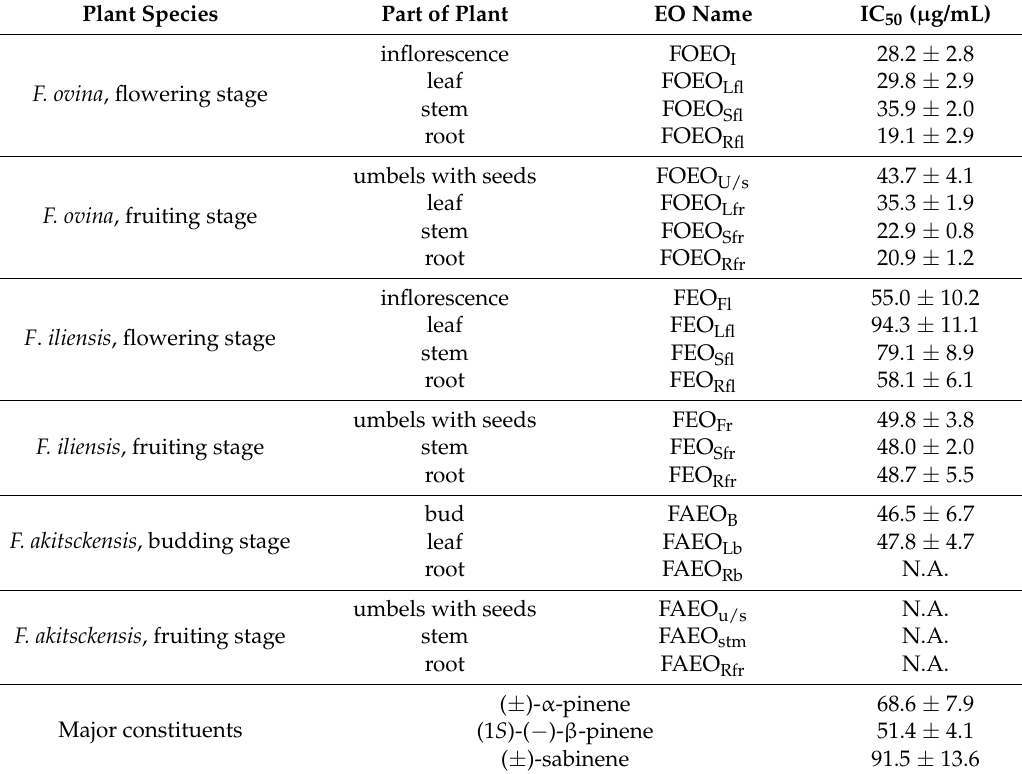
Table 2. Antibacterial screening of the EOs from F. ovina , F. iliensis , and F. akitschkensis and their major constituents against MRSA strain